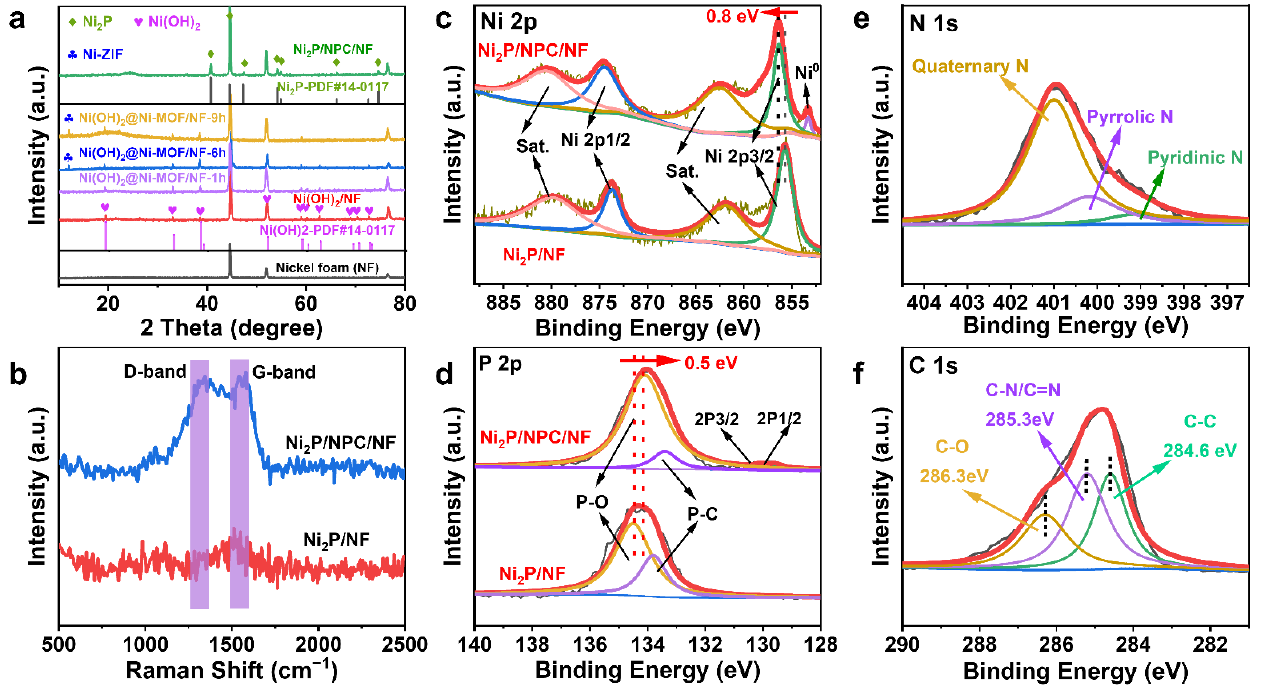
Figure 3. ( a ) XRD patterns of NF, Ni(OH) 2 /NF, Ni(OH) 2 /Ni-MOF/NF-1 h, 6 h, 9 h, Ni 2 P/NF and Ni 2 P/NPC/NF. ( b ) Raman spectra of Ni 2 P/NF and Ni 2 P/NPC/NF. XPS spectra of Ni 2 P/NPC/NF: ( c ) Ni 2p, ( d ) P 2p, ( e ) N 1s and ( f ) C 1s.